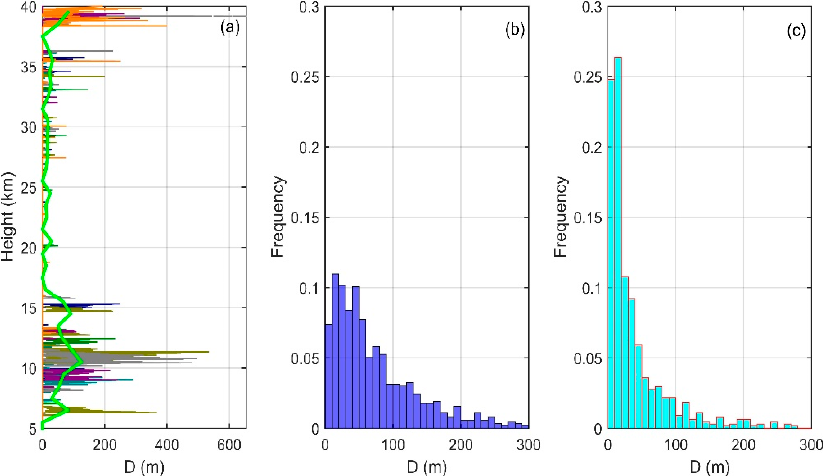
Figure 7. Vertical distribution of D ( a ) and frequency distribution of D in the troposphere ( b ) and in the stratosphere ( c ).